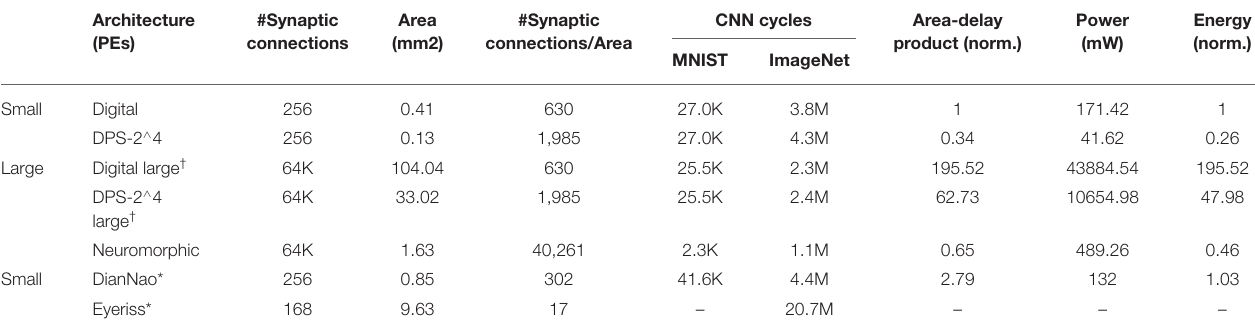
TABLE 2 | Processing element (PE) array